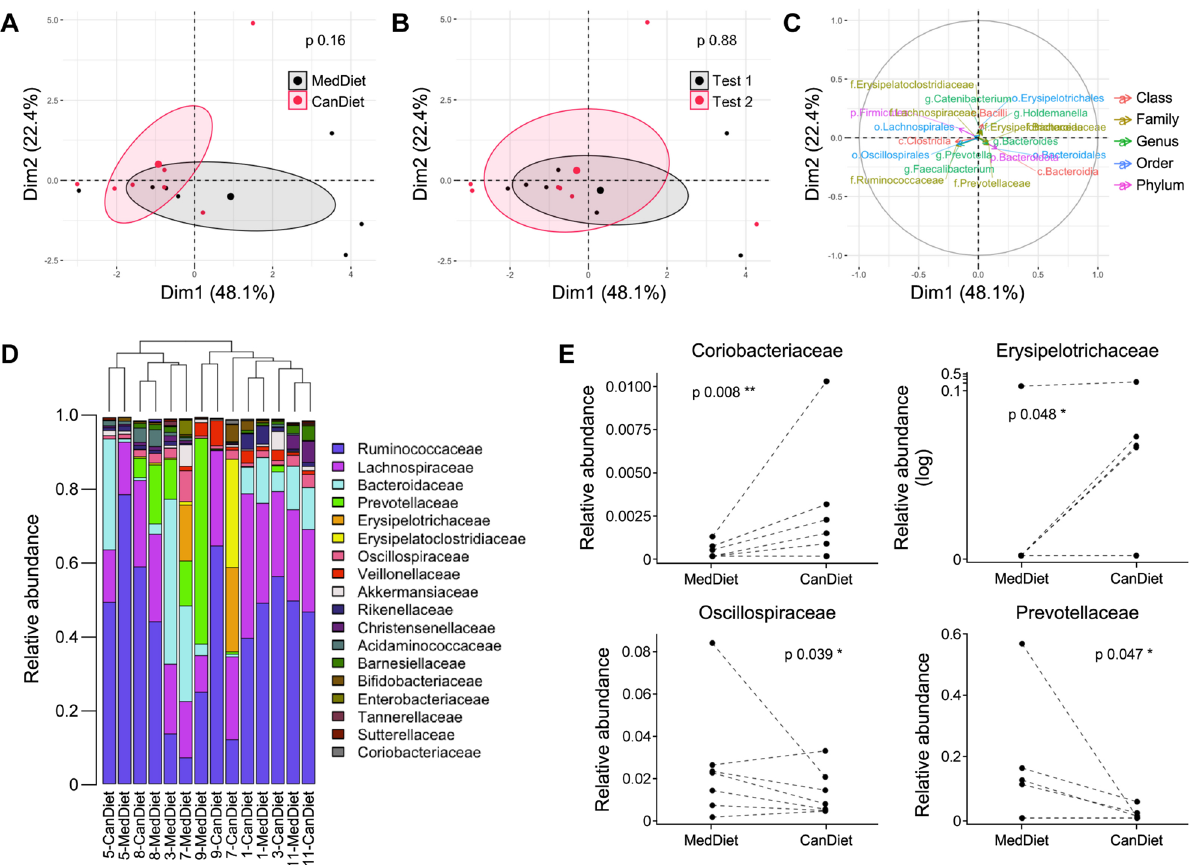
Figure 5. Multiple factor analysis (MFA) of the gut microbiota profile. Ellipses show the effect of ( A ) diet and ( B ) visit on individuals at different time points. ( C ) Loading plot shows the influence of the top 30 microbiota taxa with the highest contribution on the MFA plot. P-values on MFA were obtained by permutational multivariate analysis of variance (PERMANOVA). ( D ) Barplot representing the relative abundance of the 18 more abundant gut microbiota’s families. Dendrogram showing hierarchical clustering on Canberra distance between samples is printed above the barplot and determines the sample order. ( E ) Relative abundance of bacterial families significantly different between diet. Relative abundance of microbiota taxa has been normalized using ranked values fitted into mixed linear-effect models (LME) and differences between diets have been tested by analysis of variance (ANOVA). Significance was set at p < 0.1 (.), p < 0.05 (*), p < 0.01 (**) and p < 0.001